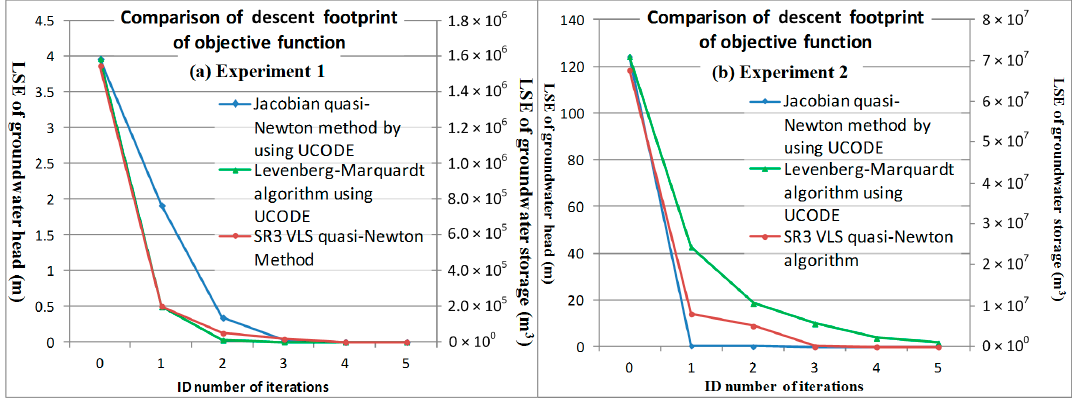
Figure 3. Comparison of descent footprint of objective function: ( a ) Experiment 1; ( b ) Experiment 2.